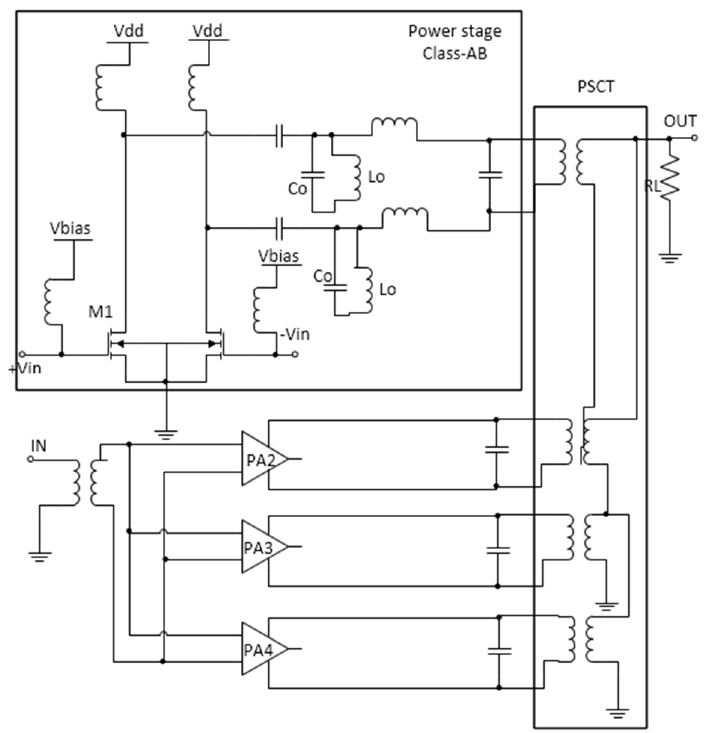
Figure 16. Schematic class-AB PA based on parallel-series power-combining transformer (PSCT) [50].